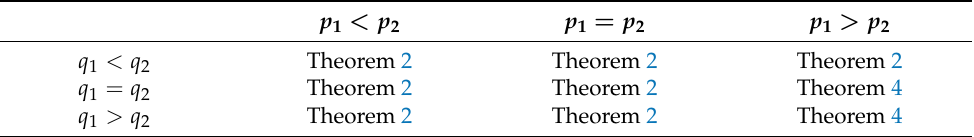
Table 1. PWM ( M p 1 q